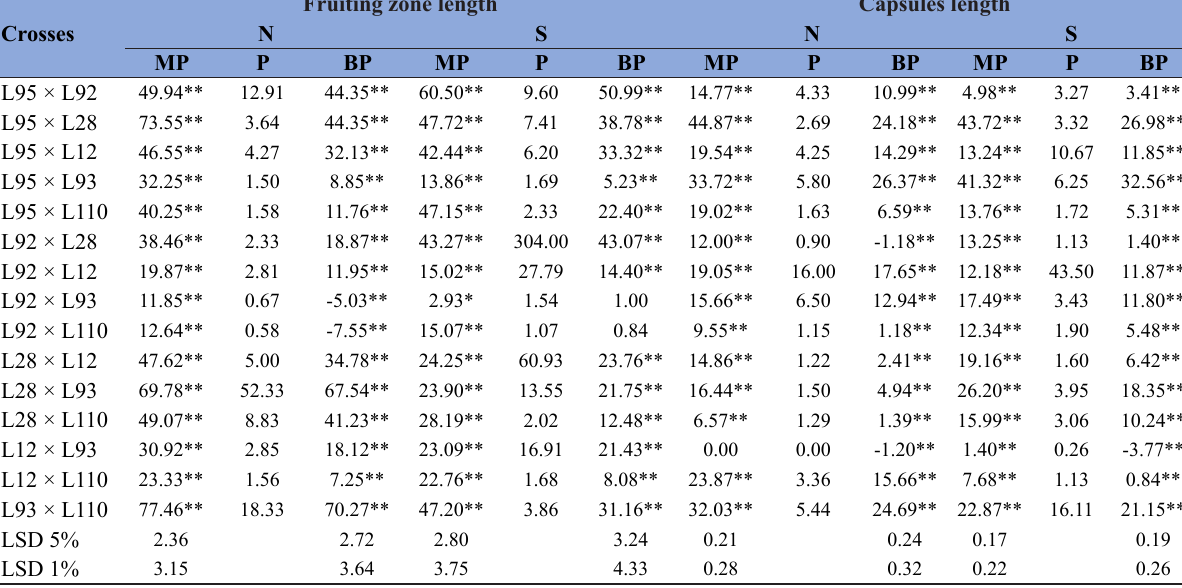
Table 10b. Relative heterosis (MP) and heterbeltiosis (BP) as well as potence ratio (P) of 15 F length and capsules length under normal irrigation (N) and water stress conditions (S) in 2019